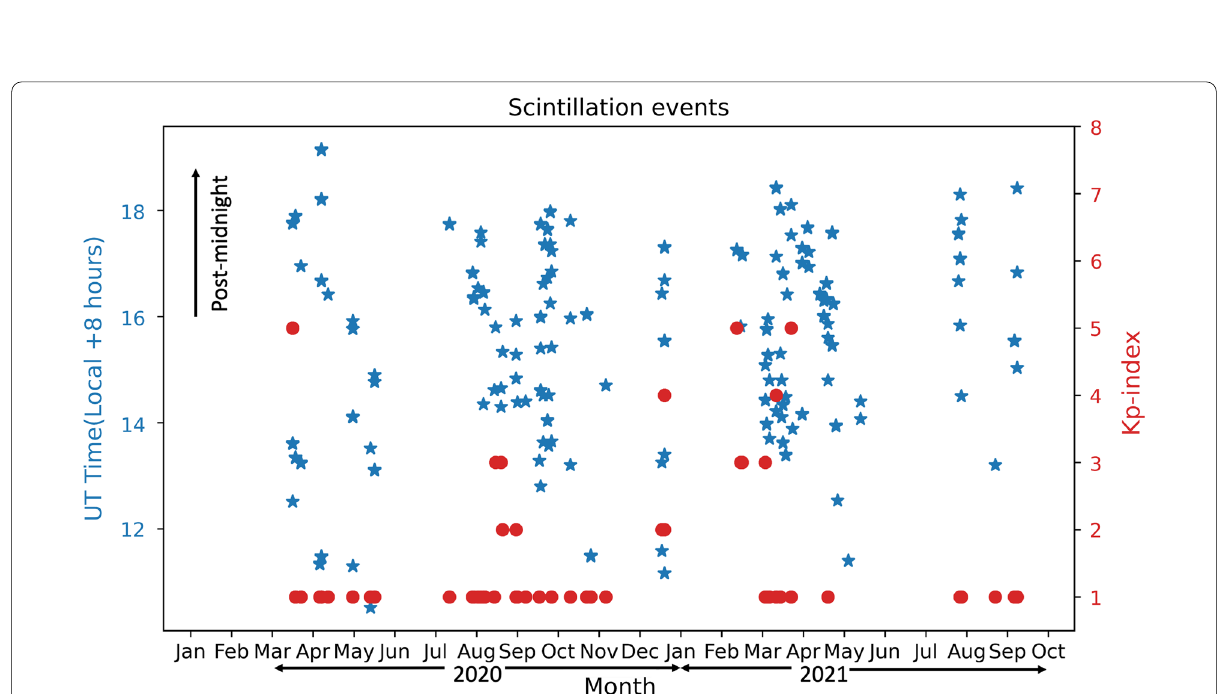
Fig. 4 The hourly occurrence and Kp index of scintillation events from Mar 2020 to Sep 2021 for 400 MHz